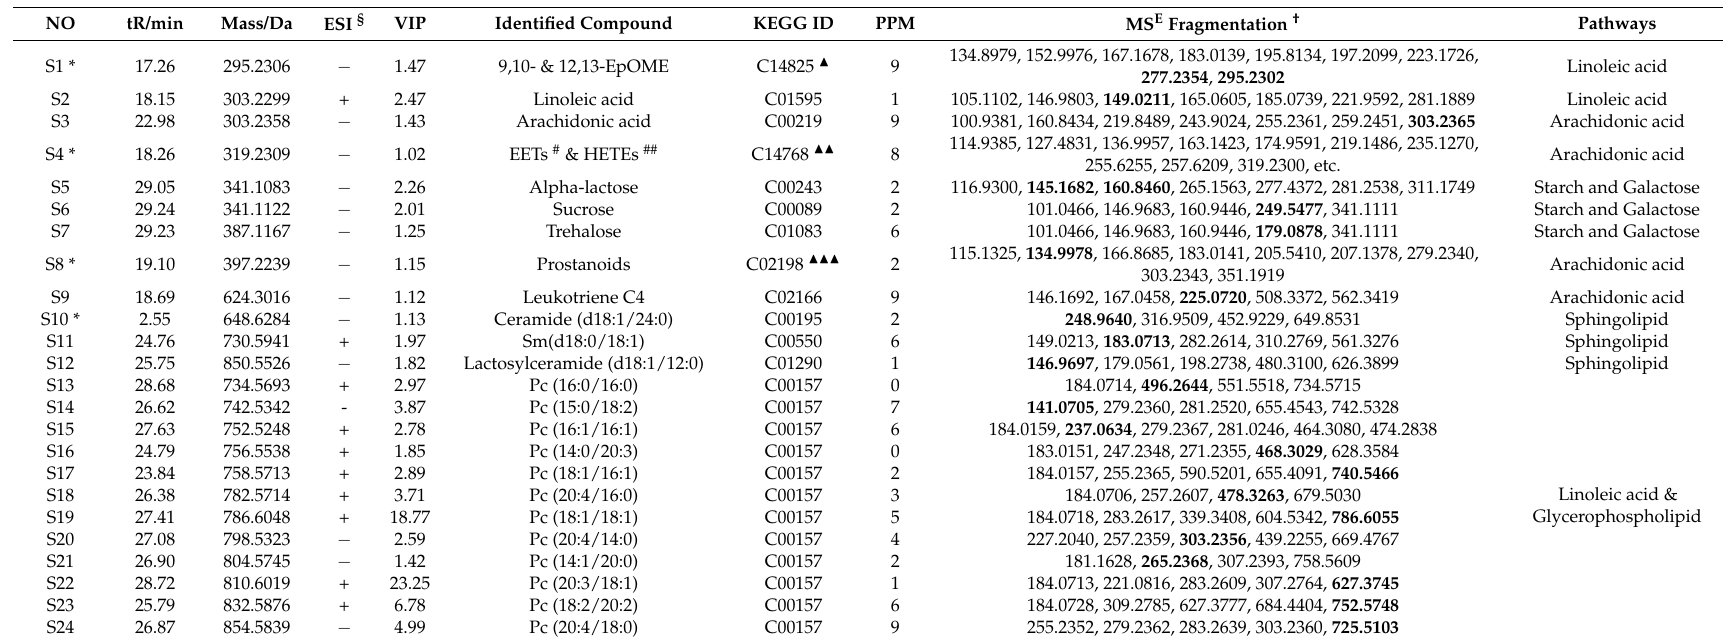
Table 1. Detailed results of all differentiated compounds identified in